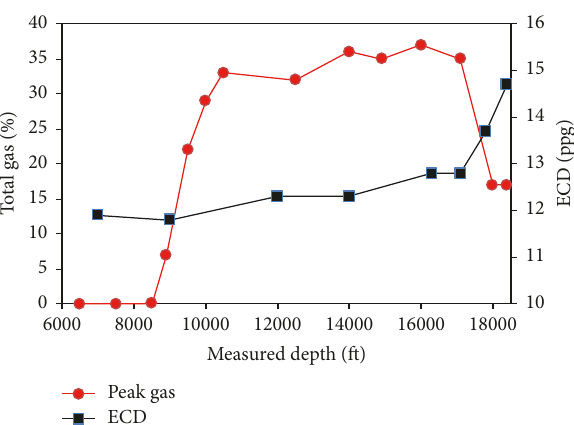
Figure 5: The total gas versus the downhole mud weight in a horizontal well (the estimated pore pressure from DFIT is 14.6 ppg).